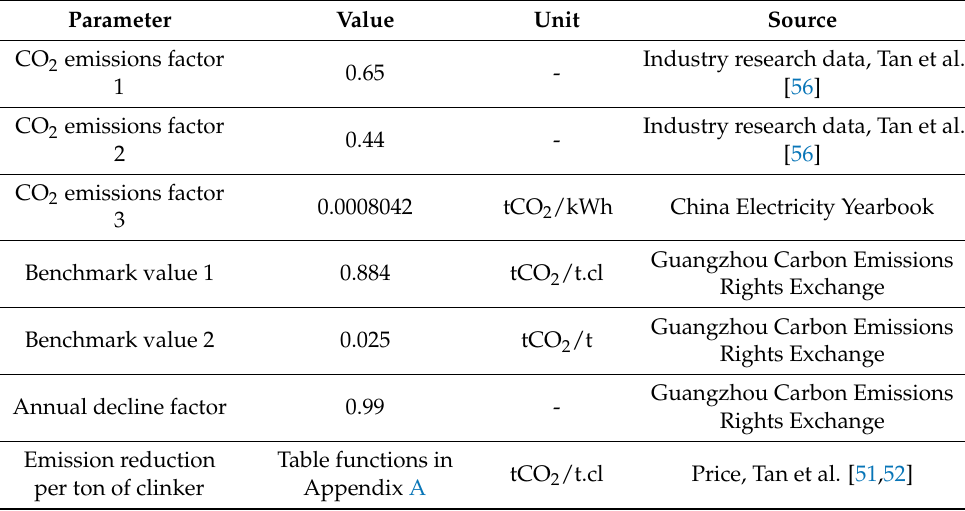
Table A3. The parameters of carbon emission and carbon trading